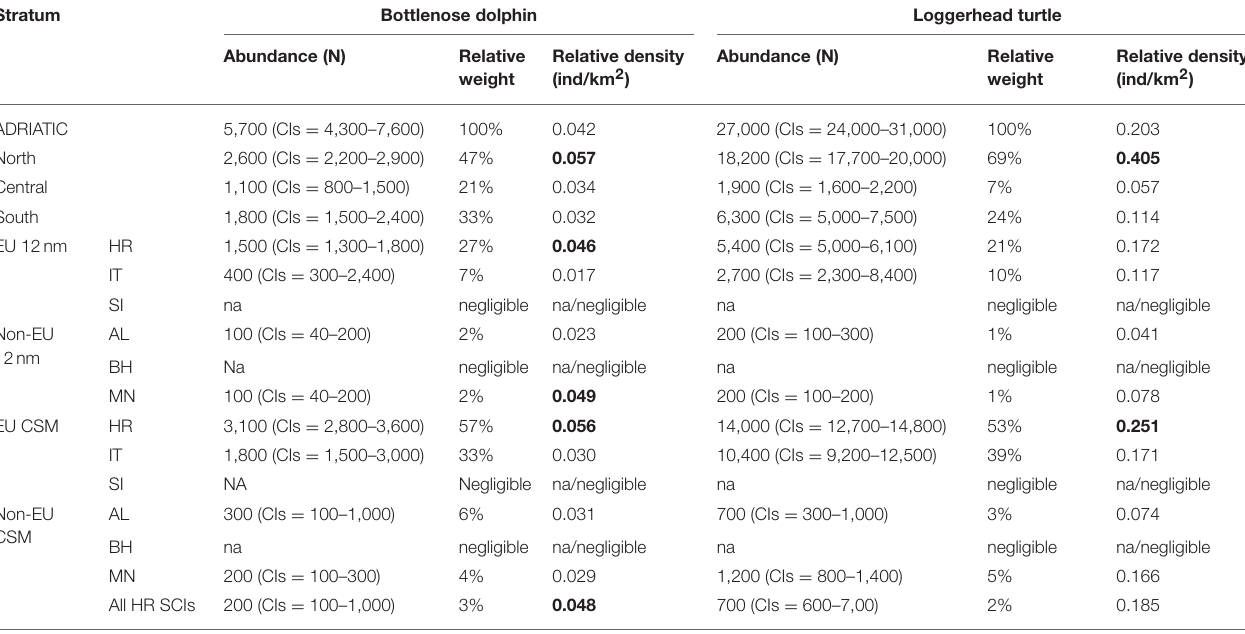
TABLE 2 | Uncorrected (see text) abundance and densities for the bottlenose dolphin and loggerhead turtles in the Adriatic Sea. Stratum Bottlenose